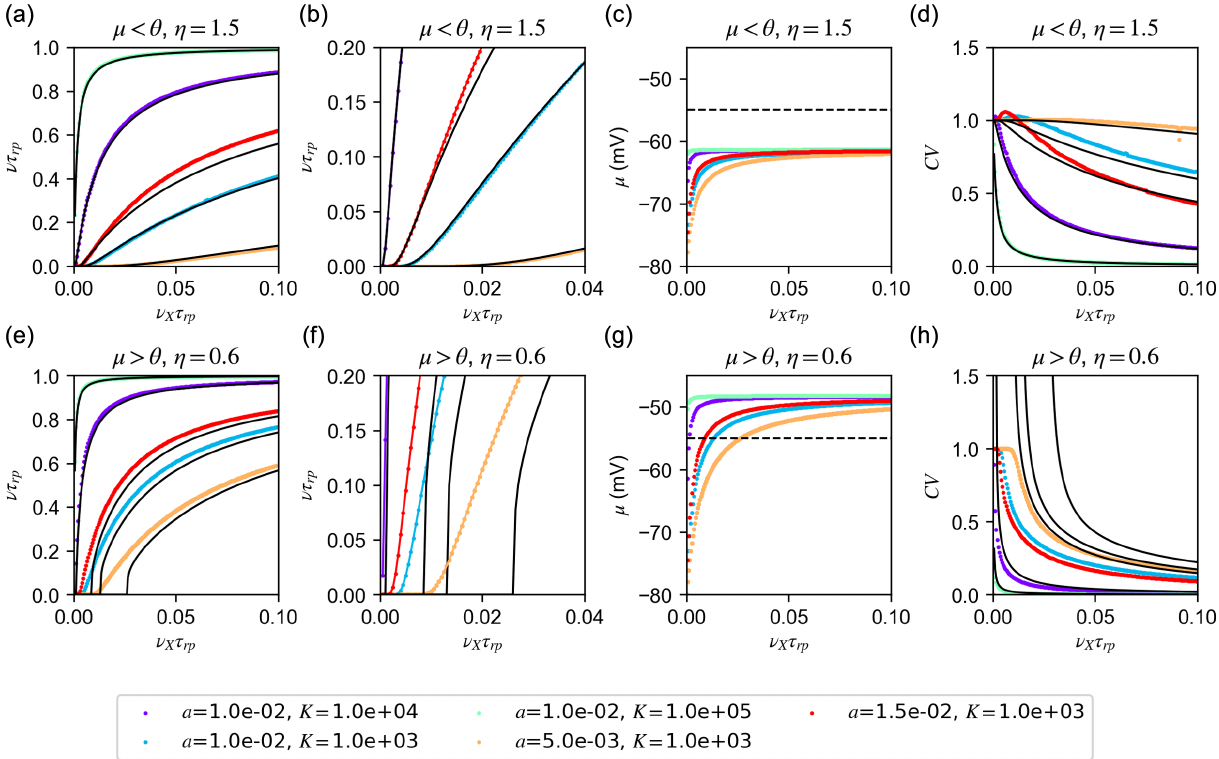
FIG. 9. Response of a single conductance-based neuron to noisy inputs. Estimates of firing rate [(a),(b),(e),(f)], μ [(c),(g)], and CV [(d),(h)] obtained with numerical integration of Eqs. (A13), (13), and (A14) for different values of a and K (colored dots). For the two regimes μ < θ (first row) and μ > θ (second row), the transfer function saturates as K increases. Note that the same change in a has a more drastic effect if μ < θ ; this is due to the exponential dependence that appears in Eq. (B6). The approximated expressions (continuous lines) capture the properties of the transfer function [(a) Eq. (B6) and (e) Eq. (B4)] and CV [(c) Eq. (B17) and (g) Eq. (B9)]. For small inputs (f), Eq. (B4) fails to describe the transfer function for some values of K , because the corresponding μ is below threshold. Simulations parameter are g ¼ 12 , γ ¼ 1 = 4 , and η ¼ 1 . 5 (top) or 0.6 (bottom).